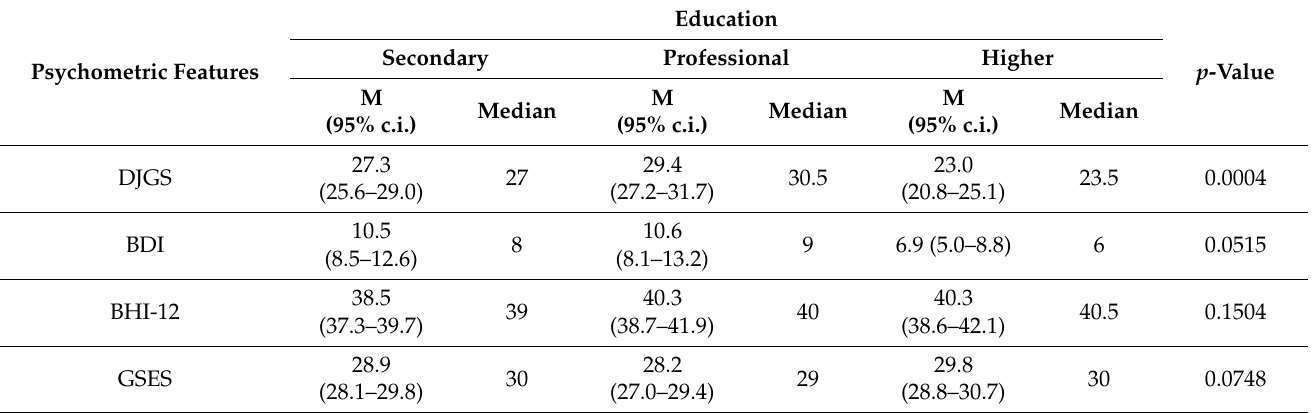
Table 6. Correlations between psychometric scales and the place of stay.